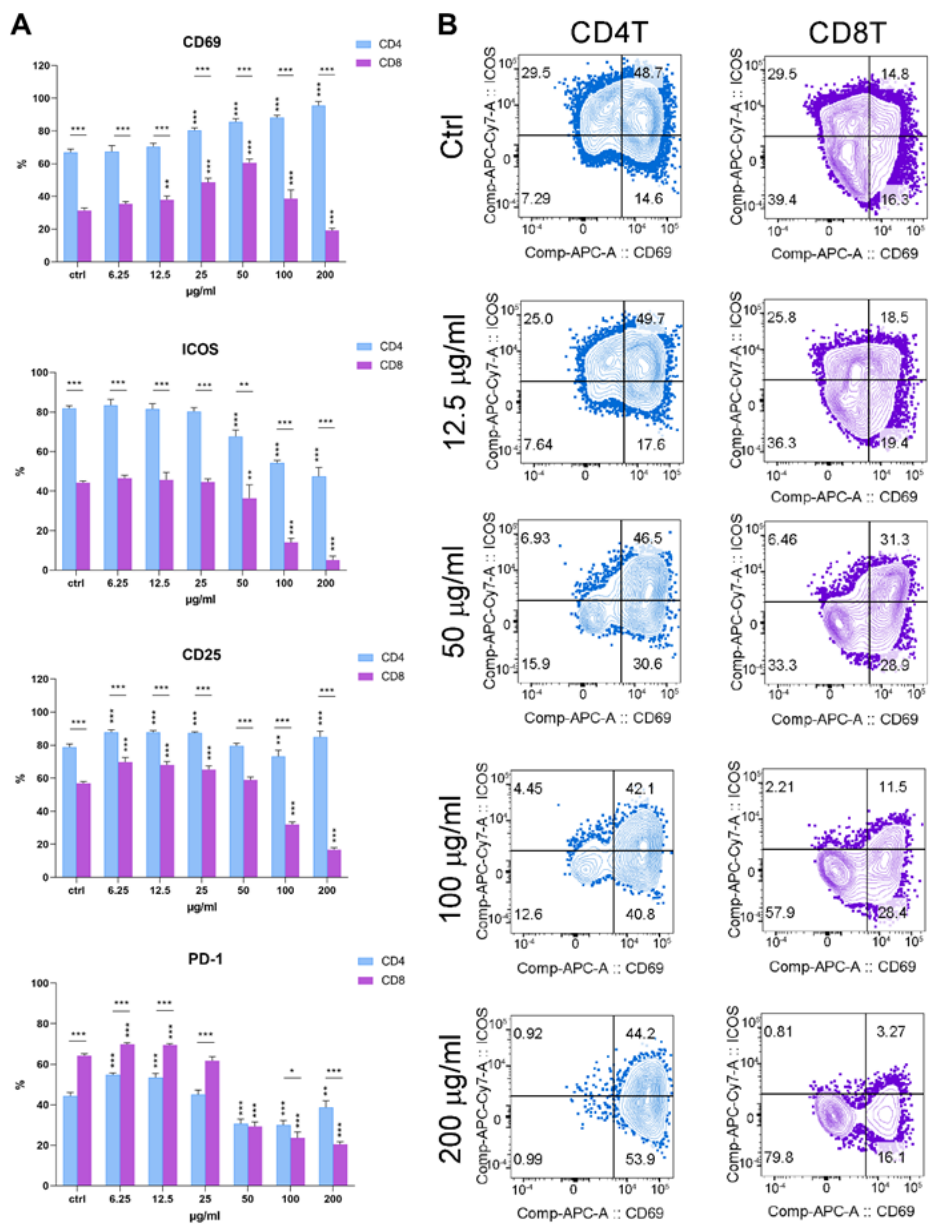
Figure 7. The effects of PoPEx on the expression of activation markers in PHA-stimulated PBMC. PBMC (3 × 10 5 /well) pre-labeled with CellTrace Far-Red were cultured with PoPEx (6.25–200 µg/mL) or without PoPEx (ctrl), and PHA (10 µg/mL) for 3 days, followed by the analysis of CD69, ICOS-1, CD25 and PD-1 on CD3 + CD4 + (CD4 T) or CD3 + CD8 + (CD8 T) T-cells. ( A ) Summarized data is shown as mean % ± SD (n = 3) of marker-positive cells and ( B ) the representative plots from one experiment, out of three with similar results, is shown. * p < 0.05, ** p < 0.01, *** p < 0.005, compared to control non-treated PHA-PBMC or as indicated by line (One-way ANOVA; Dunn’s multiple comparison post-test).